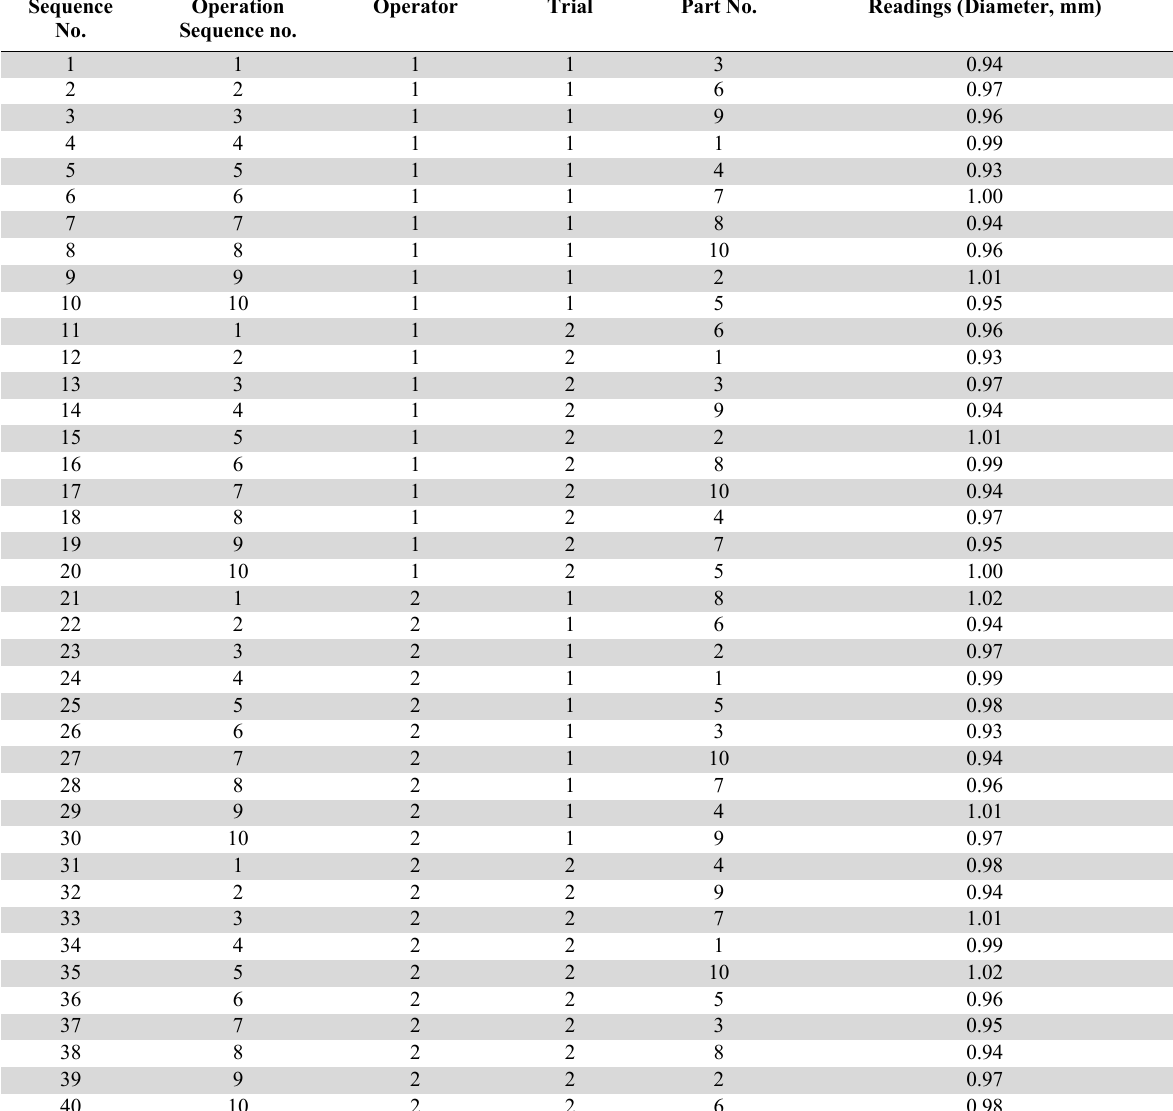
Minitab Data Sheet of Spring Diameter for Gauge R&R Study Sequence